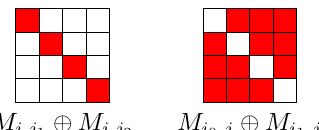
Figure 10: Illustration of the different plaintext values used for the real traces, viewed as 4 × 4 matrices of bytes. A red (resp. white) square indicates a non-zero (resp. zero)